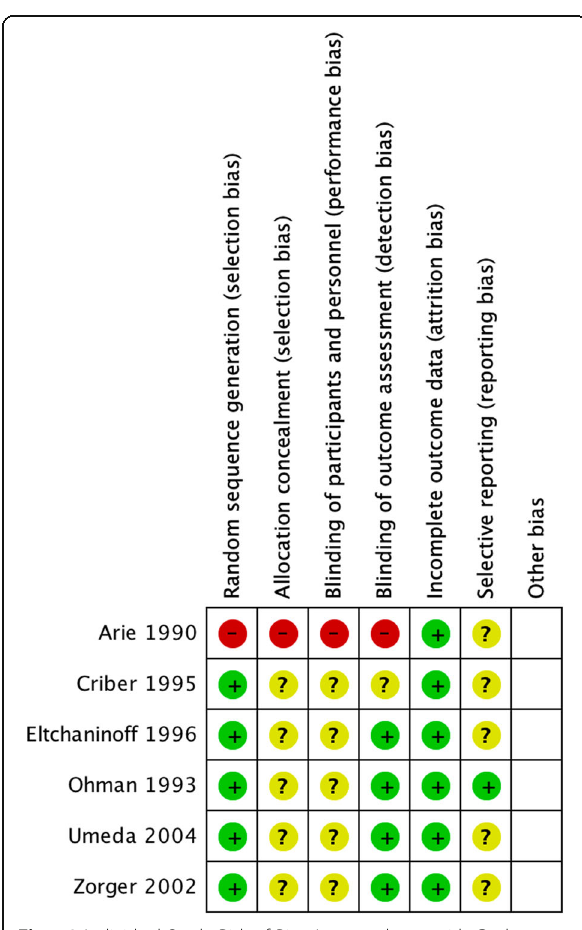
Fig. 10 Individual Study Risk of Bias. In accordance with Cochrane Guidelines, each included study was individually assessed for risk of